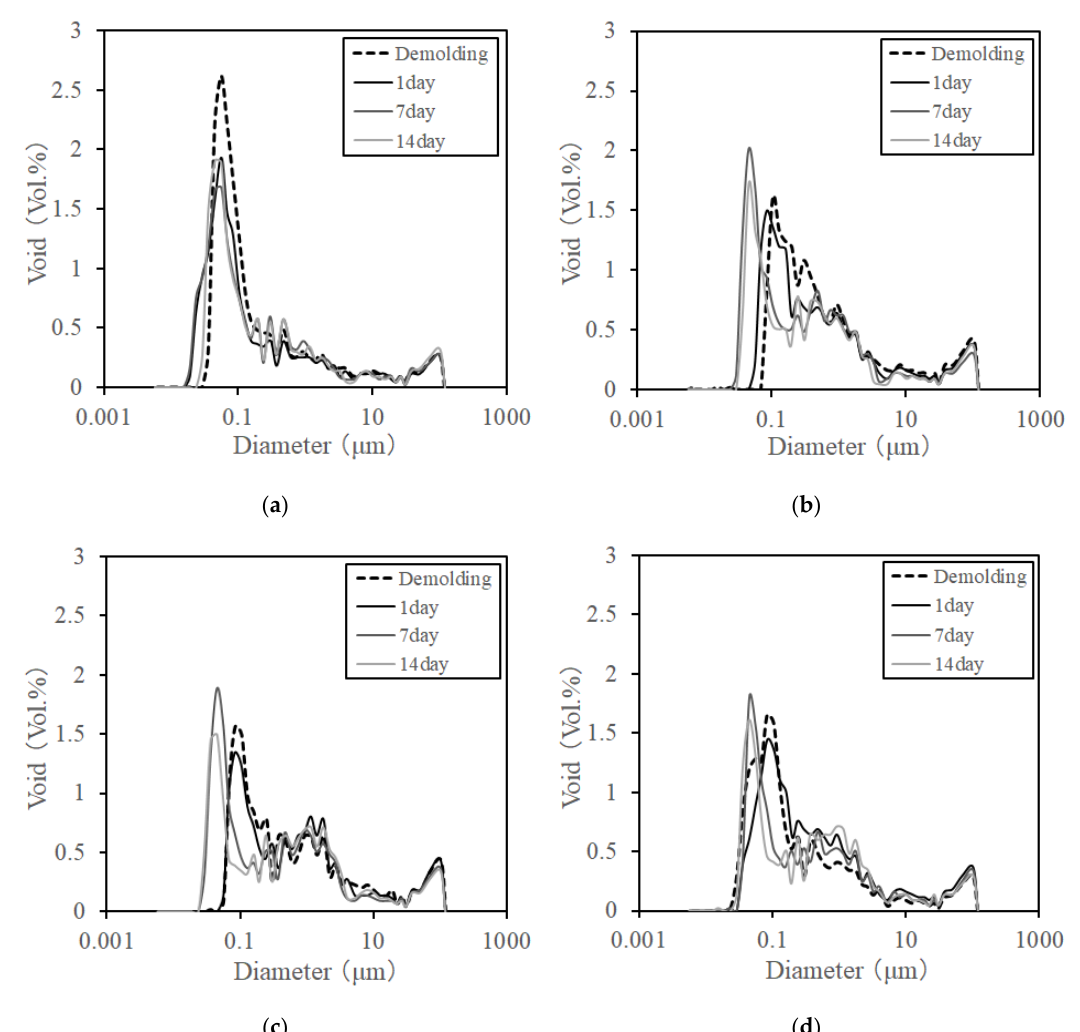
Figure 14. Porosity of concrete. ( a ) Steam curing, ( b ) MW1, ( c ) MW2, ( d ) MW3.